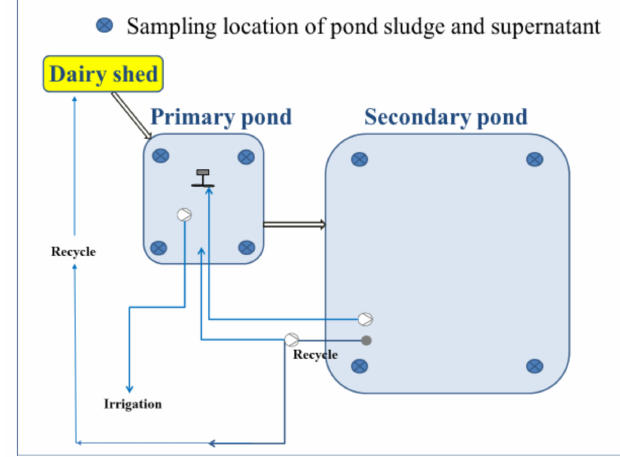
Figure 3. Pond sludge and supernatant collection points.